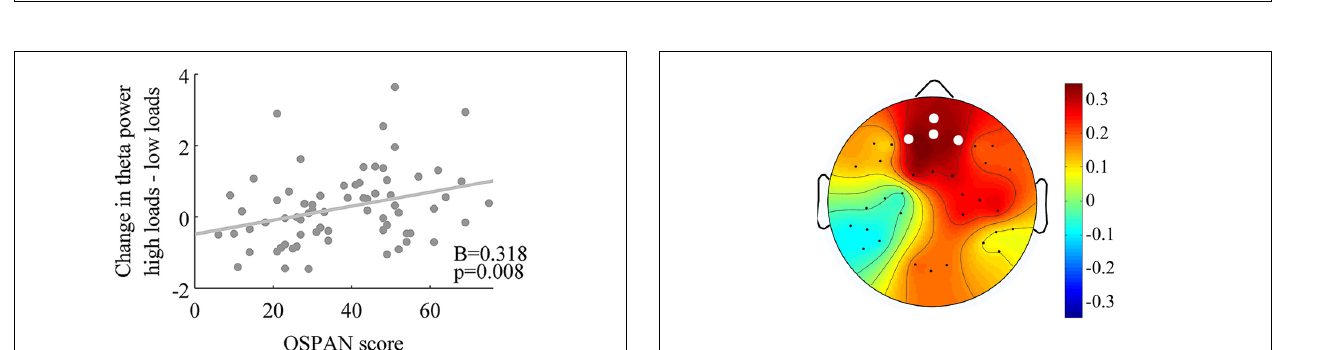
explain why the differences between max load (load five) and max